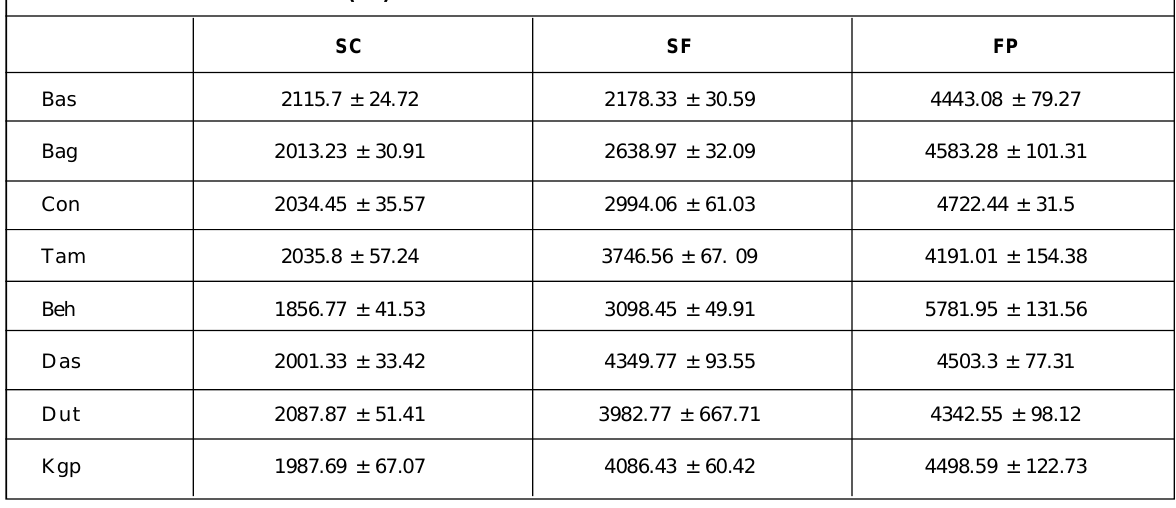
Table 4: Variation in calcium (Ca)